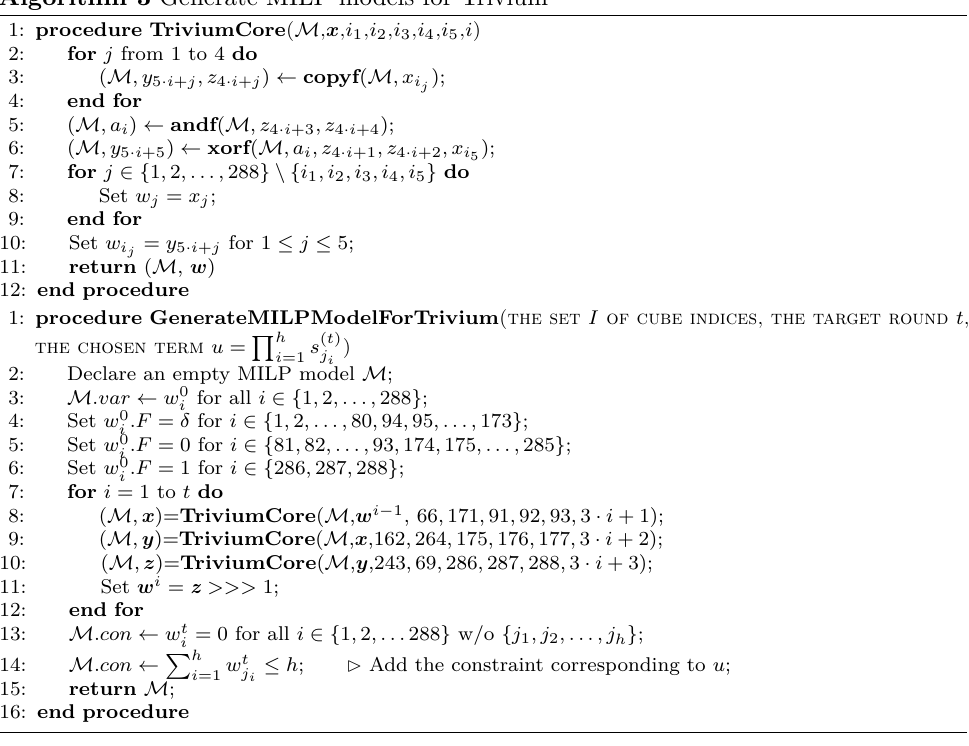
Algorithm 3 Generate MILP models for